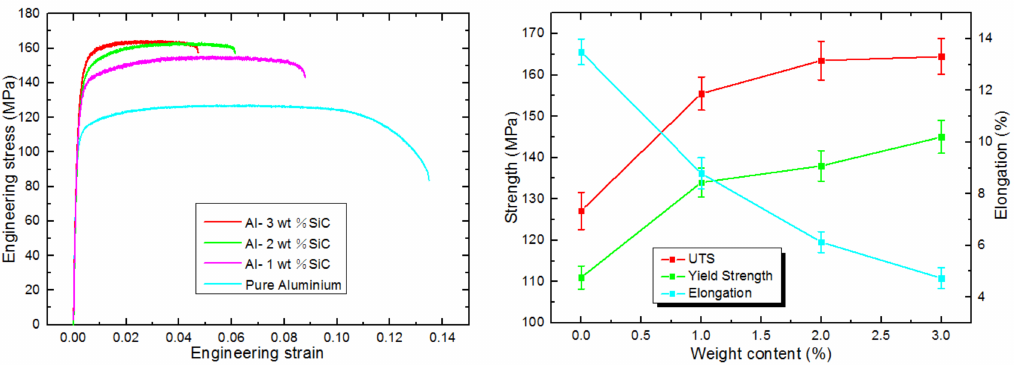
Figure 8. Tensile stress-strain curve of pure aluminum and Al-SiC nanocomposites at room